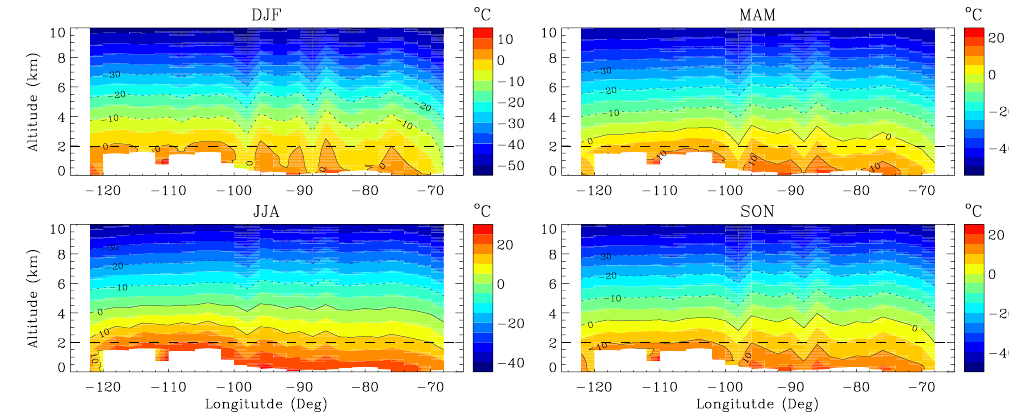
Fig. 9. Longitude-altitude distributions of the meridionally averaged temperature over 56 stations in different seasons.